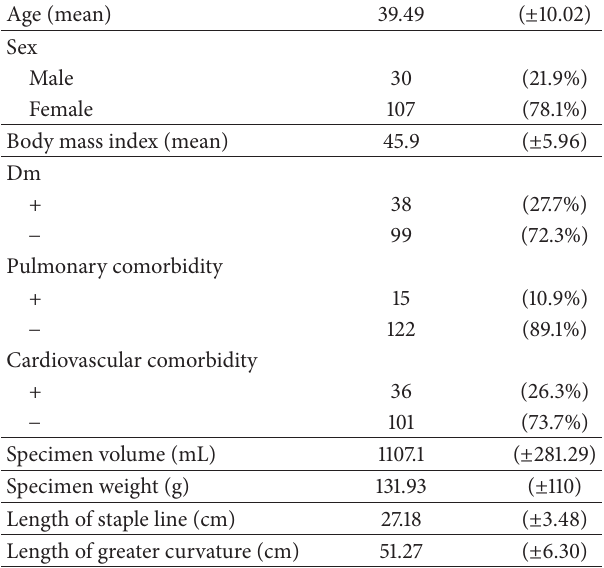
Table 1: Patient characteristics and specimen